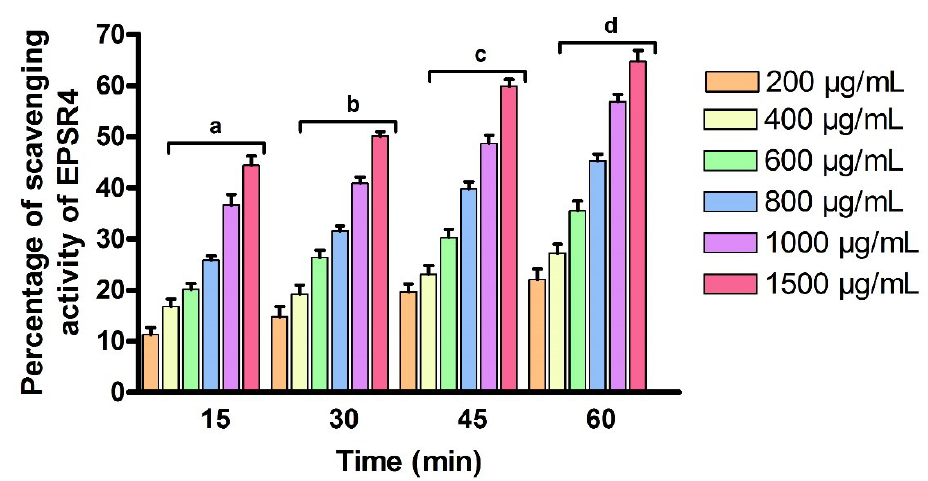
Figure 9. The activity of EPSR4 to scavenge the free radical of hydrogen peroxide at different time intervals. Data are presented as mean ± SD. a p < 0.05 versus concentration of 200 µ g/mL in 15 min, b p < 0.05 versus concentration of 200 µ g/mL in 30 min, c p < 0.05 versus concentration of 200 µ g/mL in 45 min, d p < 0.05 versus concentration of 200 µ g/mL in 60 min.